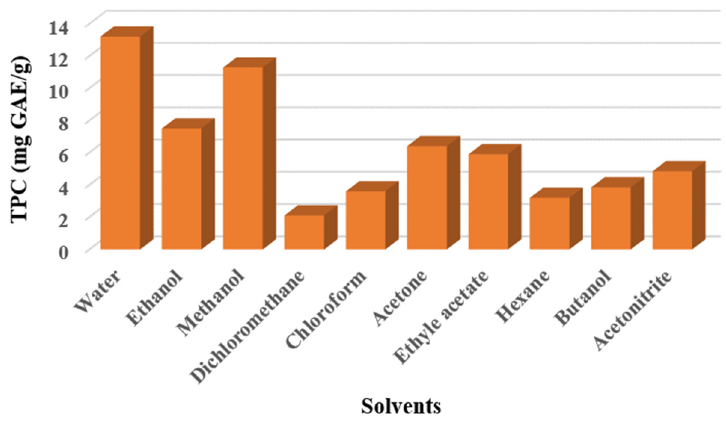
Figure 2. Total phenolic compounds extracted from P. anisum seeds using different solvents.